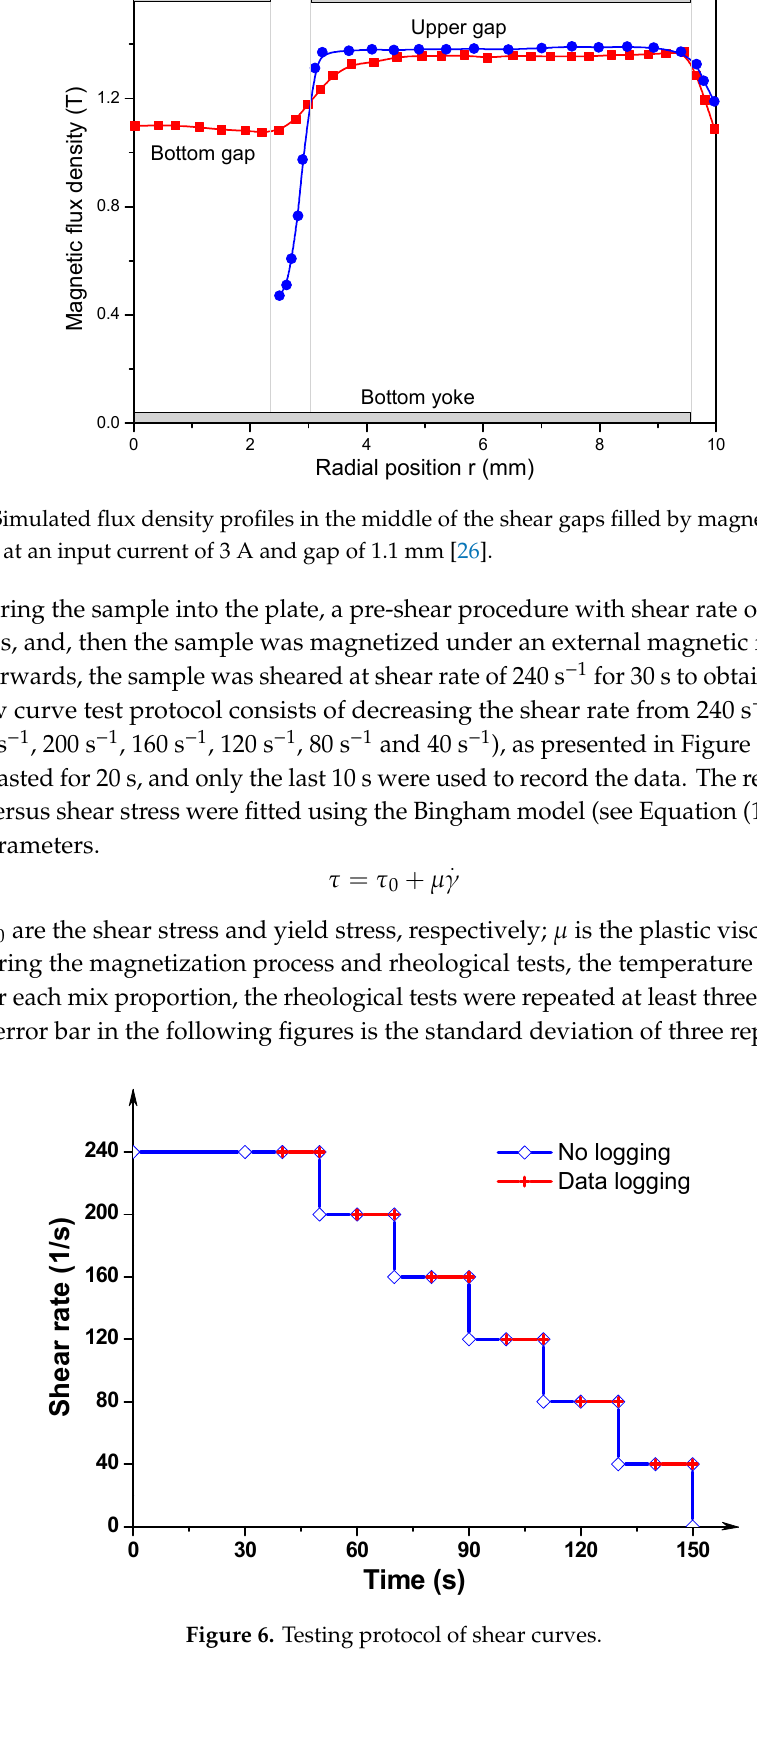
Figure 6. Testing protocol of shear curves.